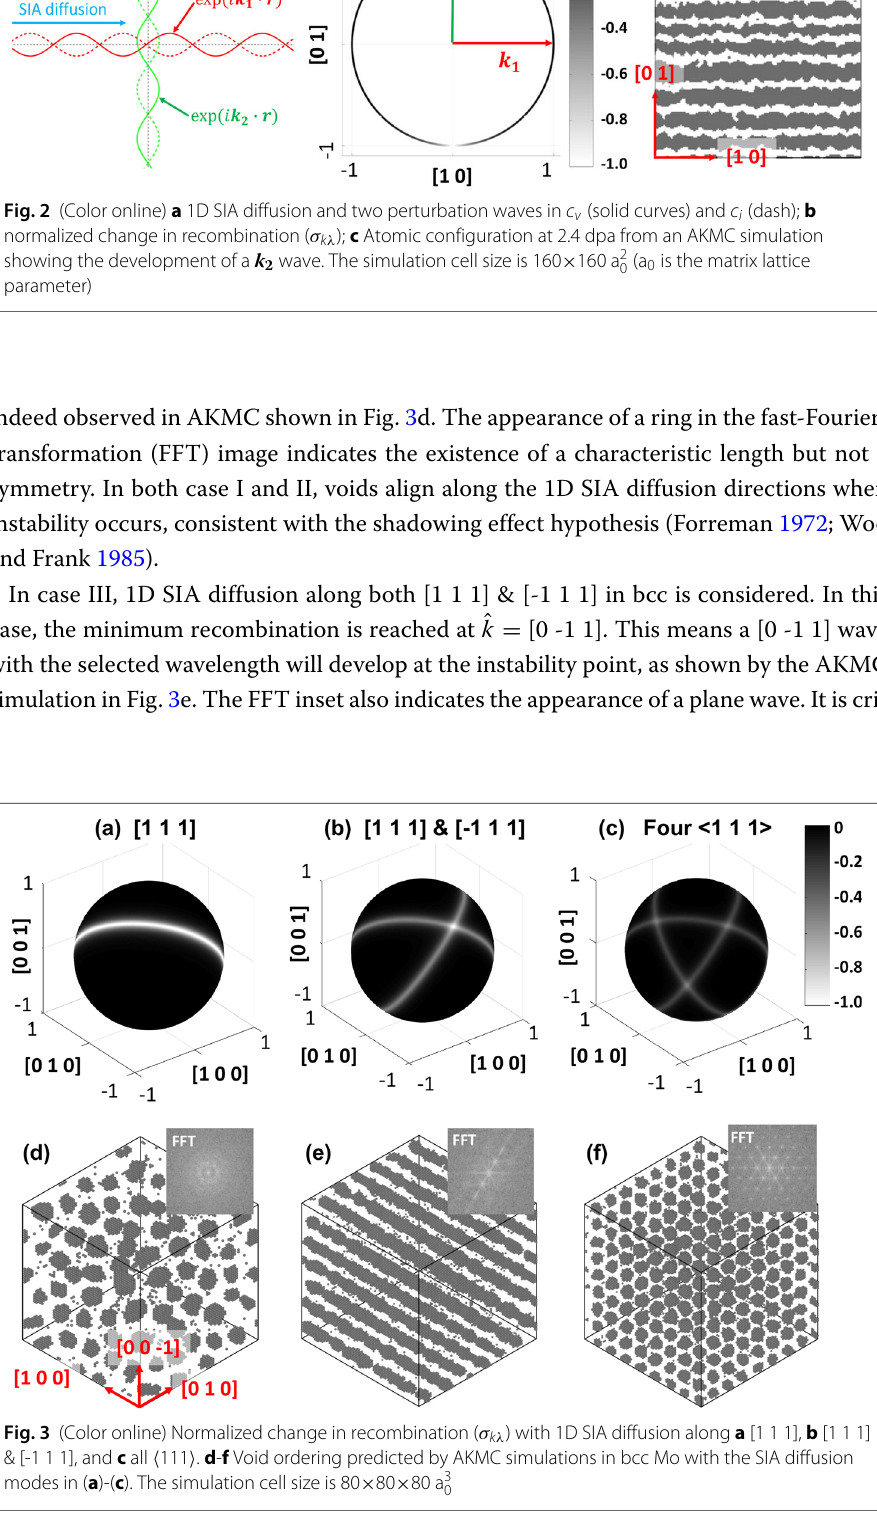
Fig. 3 (Color online) Normalized change in recombination ( σ k λ ) with 1D SIA diffusion along a [1 1 1], b [1 1 1] & [-1 1 1], and c all (cid:5) 111 (cid:6) . d - f Void ordering predicted by AKMC simulations in bcc Mo with the SIA diffusion modes in ( a )-( c ). The simulation cell size is 80 × 80 × 80 a 3